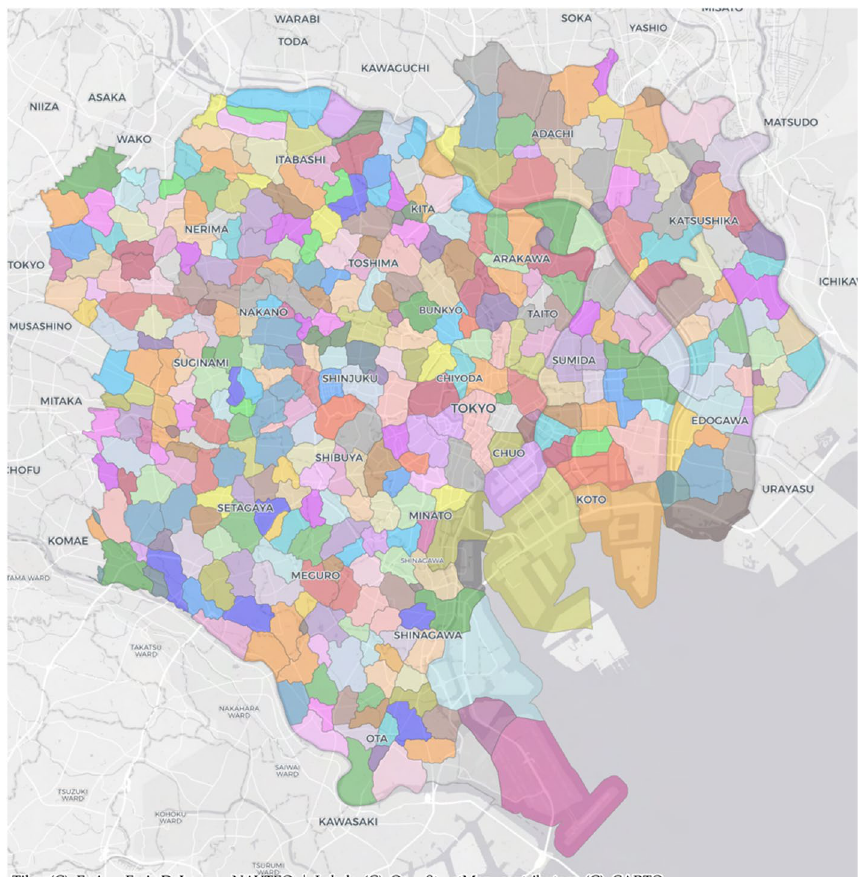
Fig. 12 Discovered neighborhoods for the 23 ward region using all variables on 200 m subgraphs